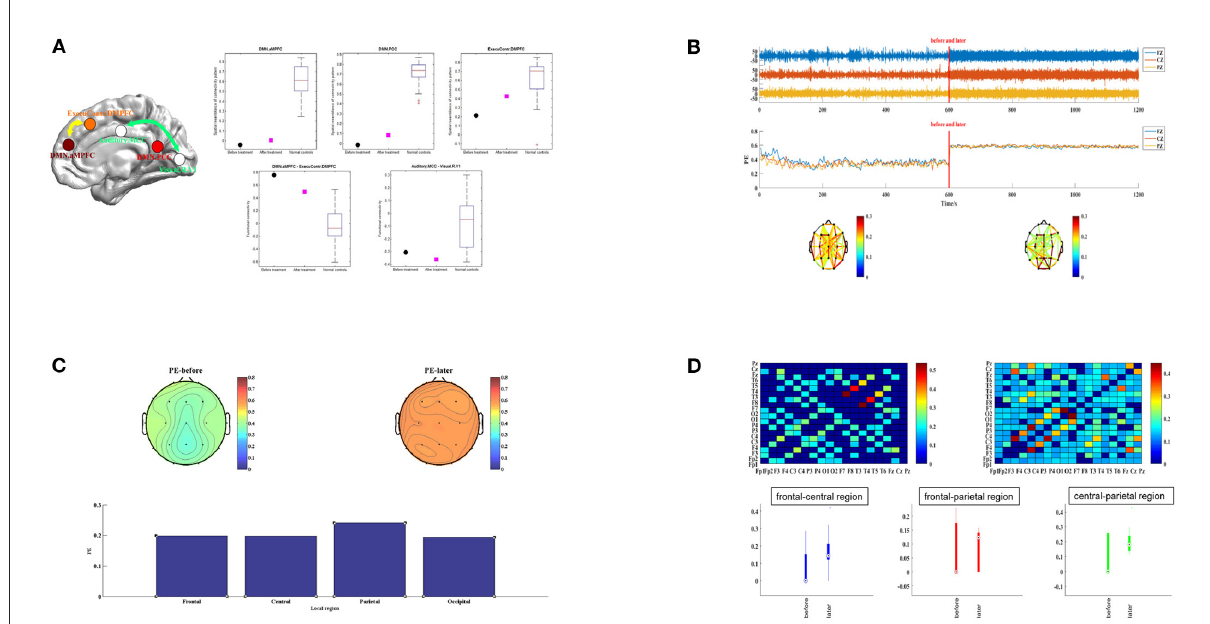
FIGURE1 The functional connection mode of the patient before and after treatment. (A) The left subplot shows the five imaging features using the package “pDoC.” In the right subplots, the black circles represent the responding imaging measurements of the patient before treatment, and the cyan squares represent the measurements after treatment. The boxplot in each subplot represents the measurement of a group of normal controls. (B) EEG activity of patients in different periods. Images of brain amplitude, activity, and complexity before and after st-SCS treatment are presented separately. (C) Topographic map distribution and local change rate of PE in different periods. Topographic maps before and after st-SCS treatment are presented in the upper part. PE changes in the frontal, central, parietal and occipital are presented in the below column. (D) Recurrence plot of information interaction and brain interval change. The recurrence plot was shown in the upper part. The connectivity changes before and after treatment are compared between the frontal-central, frontal-parietal, and central-parietal brain regions below.